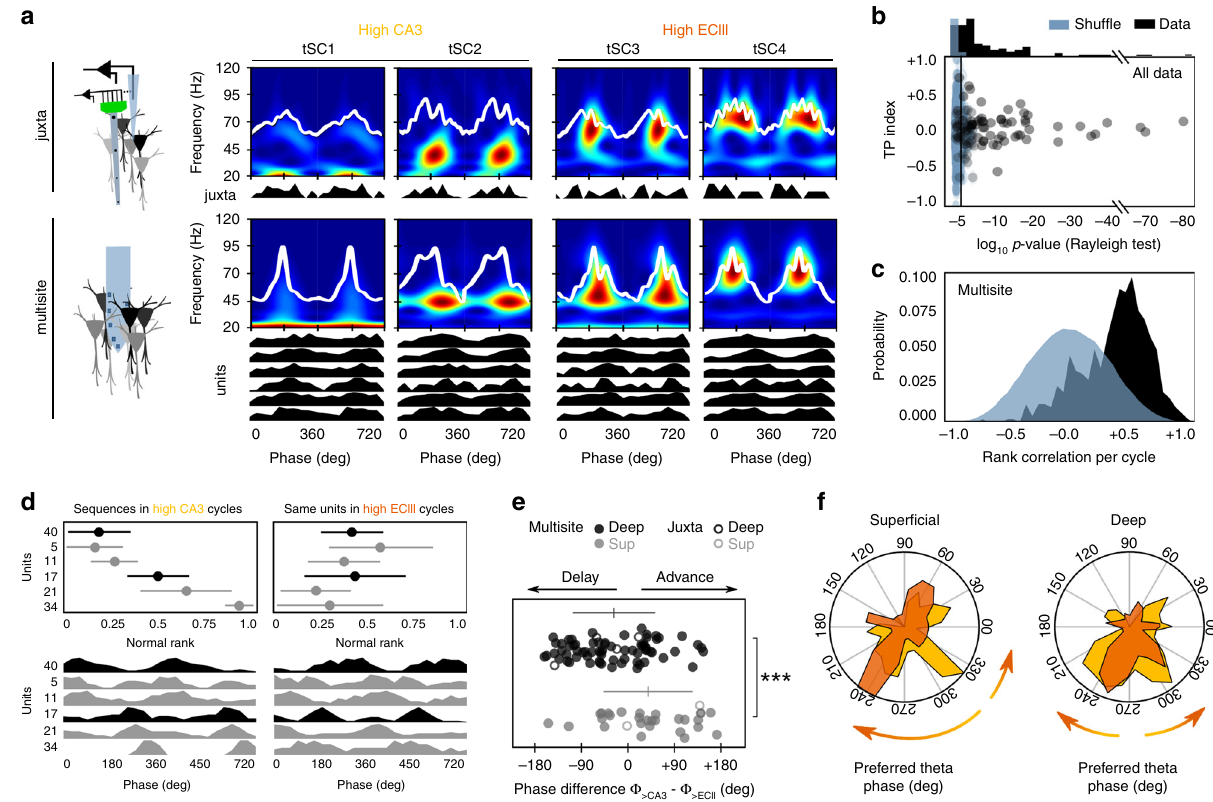
Fig. 5 Dynamic phase shifts of deep and super fi cial CA1 pyramidal cells. a Unsupervised classi fi cation of theta cycles in different classes allowed evaluating changes of fi ring dynamics from single-cells recorded juxtacelullarly and using multisite probes. Cycles classi fi ed as tSC1 and 2 are associated to larger CA3 inputs (yellow) while tSC3 and 4 re fl ect larger entorhinal layer III inputs (orange). b Results from the surrogate tests (1000 shuf fl es) on signi fi cant theta modulation of single-cell data during theta cycles subclasses. Only cells/units meeting signi fi cance ( p < 0.05 Rayleigh test) for both tSC1-2 and tSC3-4 fi ring histograms were considered for further analysis ( n = 7 juxtacellular cells, n = 96 units from multisite recording). c Rank order tests were used to identify sequences of units repeating consistently across classi fi ed theta cycles as tested against chance order (500 shuf fl es). d Example of the effect of high ECIII versus high CA3 inputs in deep and super fi cial units fi ring together over several theta cycles. Upper plots show mean rank order ± SD for each unit for all high CA3 (from up to bottom: 19, 13, 17, 17, 18, and 10 cycles) versus high ECIII cycles (from up to bottom: 13, 15, 13, 12, 14, and 13 cycles). Bottom plots show same data plotted as theta phase fi ring histograms. The order was established by high CA3 cycles. Note signi fi cant phase shift of putative super fi cial units #21 and 34 at bottom and the deep unit #40 at top. e Phase shift differences (high CA3 phase – high ECIII phase) caused by tSC3-4 cycles (>ECIII) vs. tSC1-2 cycles (>CA3) in deep and super fi cial cells. Data from juxtacellular (4 deep and 3 super fi cial cells; open dots) and multisite recordings (70 deep and 26 super fi cial units; fi lled dots). Horizontal lines indicate mean±SD from each sublayer (deep: black; super fi cial: gray). Circular ANOVA, F(1,101) = 14.3, p = 0.0003 for all cells together; F(1,5) = 4.8, p = 0.0795 for juxtacellular cells alone; *** p <0.001. f Mean population polar plots showing phase shift effects of high ECIII inputs in deep and super fi cial cells separately. Same data set as in ( e ). The arrows re fl ect the main trends reported in ( e